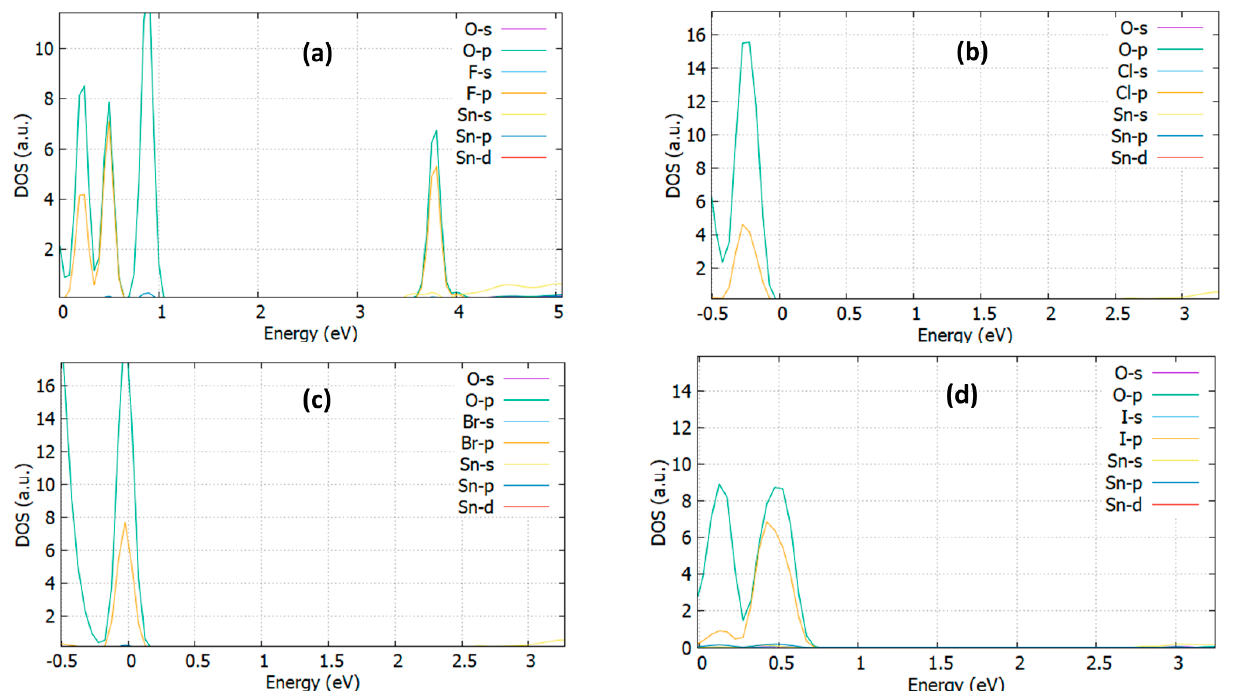
Figure 4. ( a ) The gap states of the F i doped SnO 2 ; ( b ) The gap states of the Cl i doped SnO 2 ; ( c ) The gap states of Br i doped SnO 2 ; ( d ) The gap states of I i doped SnO 2 .